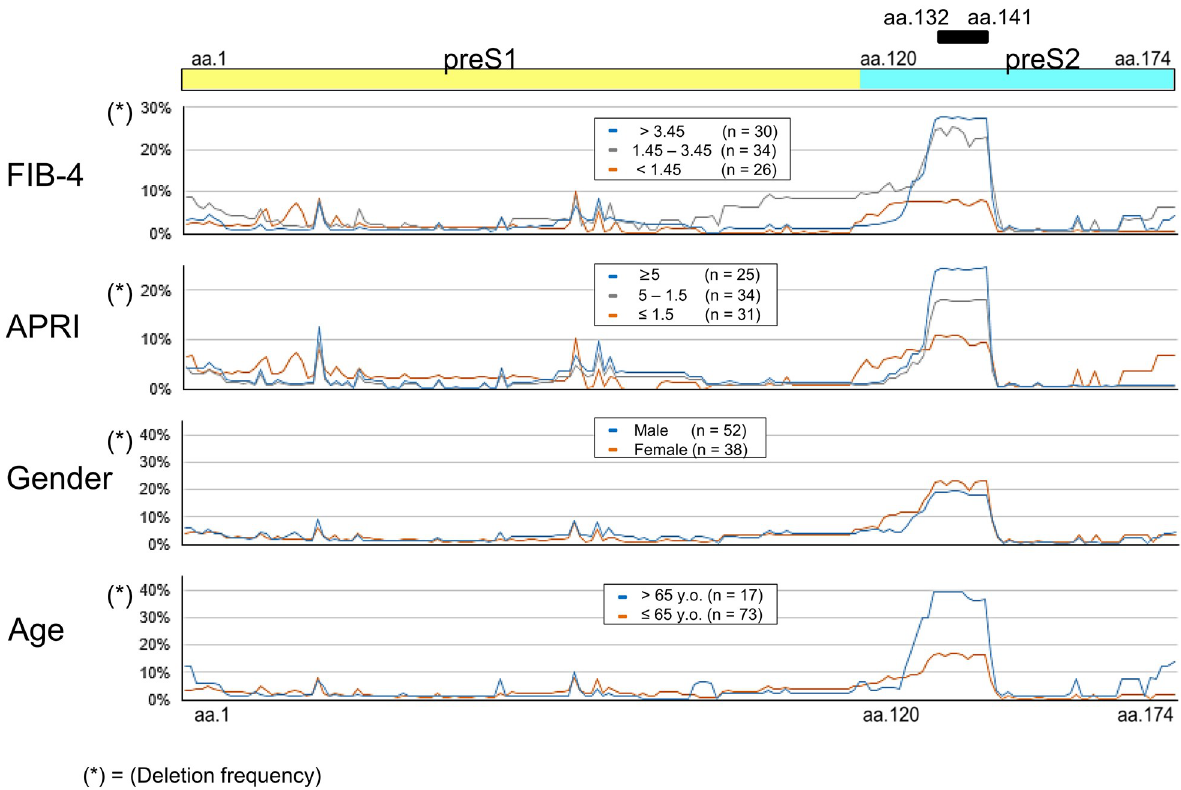
Fig 2. PreS deletion frequency and its association with clinical factors. PreS deletion frequency and its association with gender, age and clinical factors (FIB-4 and APRI). A. The patients were stratified into three groups according to their FIB-4 values (over 3.45; n = 30, 1.45–3.45; n = 34, and < 1.45; n = 26). B. The patients were stratified into three groups (5 � ; n = 25, 5–1.5; n = 34, and � 1.5; n = 31) according to their APRI values. C. The patients were divided into two groups according to their sex (male; n = 52, female; n = 38). D. The patients were stratified into two groups according to their age ( > 65 y.o., n = 17, � 65 y.o., n =